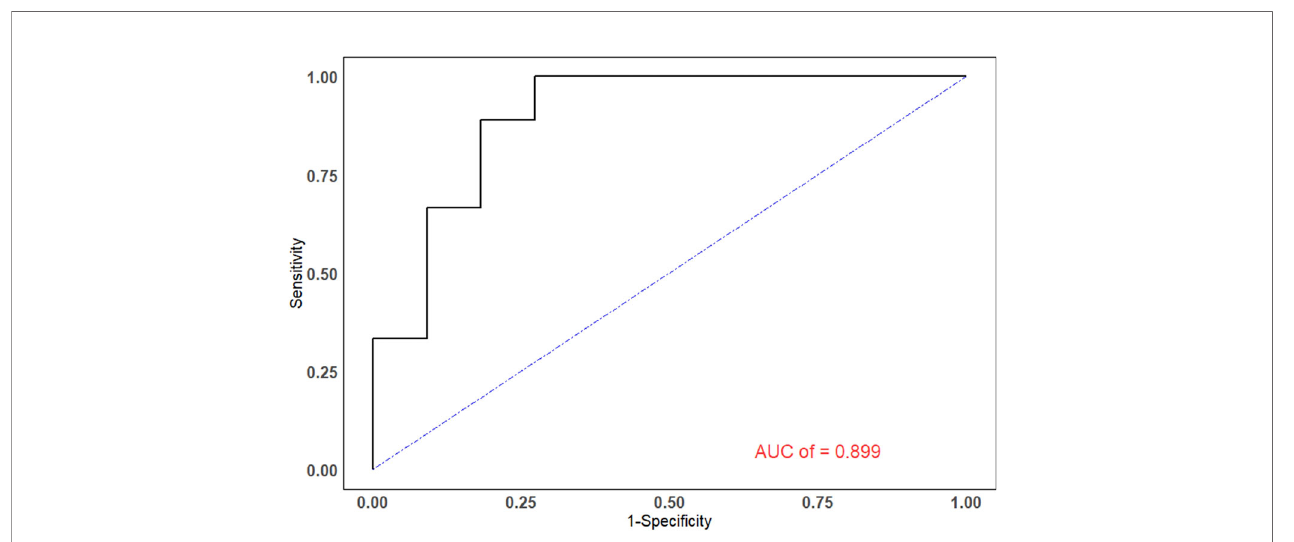
FIGURE 2 | The ROC curves of TLR. The areas under the ROC curves for the ability to predict pathological treatment response for TLR was